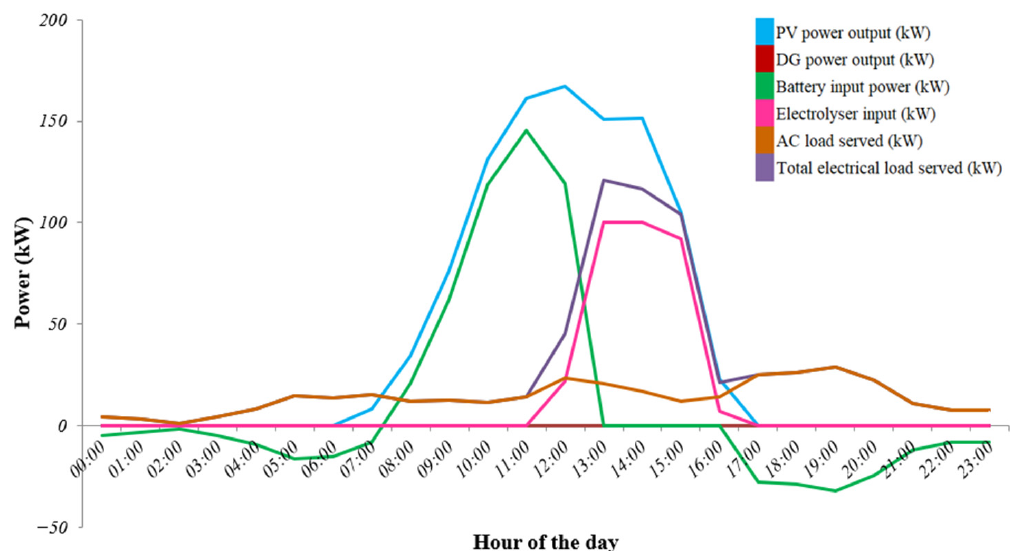
Figure 17. Time series analysis for 24 h operation of HEGS.